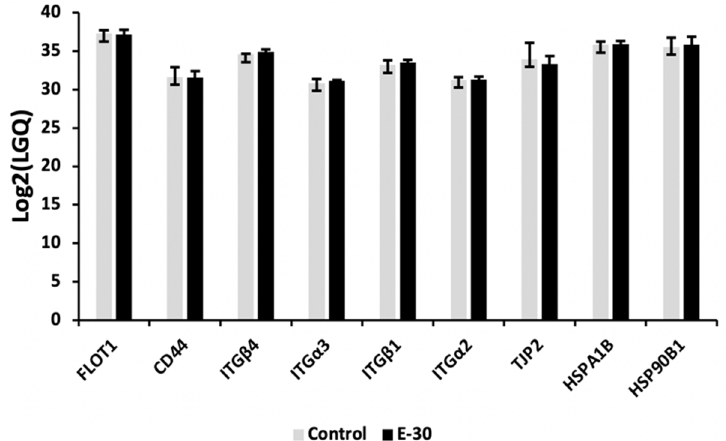
Figure 3. Expression of typical proteins present in the lipid raft microdomains. The graph represents label free quantification (LFQ) from lipid raft isolation of HIBCPP cells proteins in uninfected control versus E-30 infected MOI 20. The graph shows the Log2 (LFQ) mean calculated from 3 independent experiments.